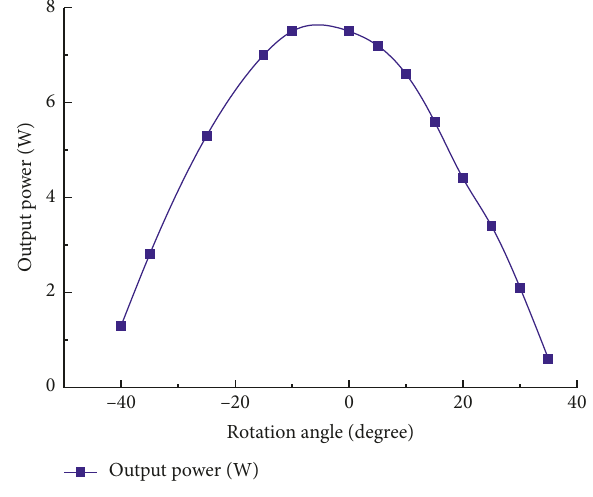
Figure 18: Output voltage-direction